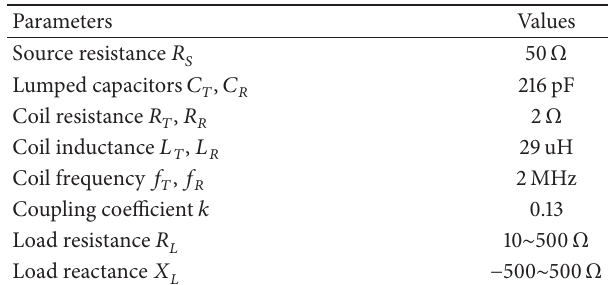
Table 1: Parameters used for